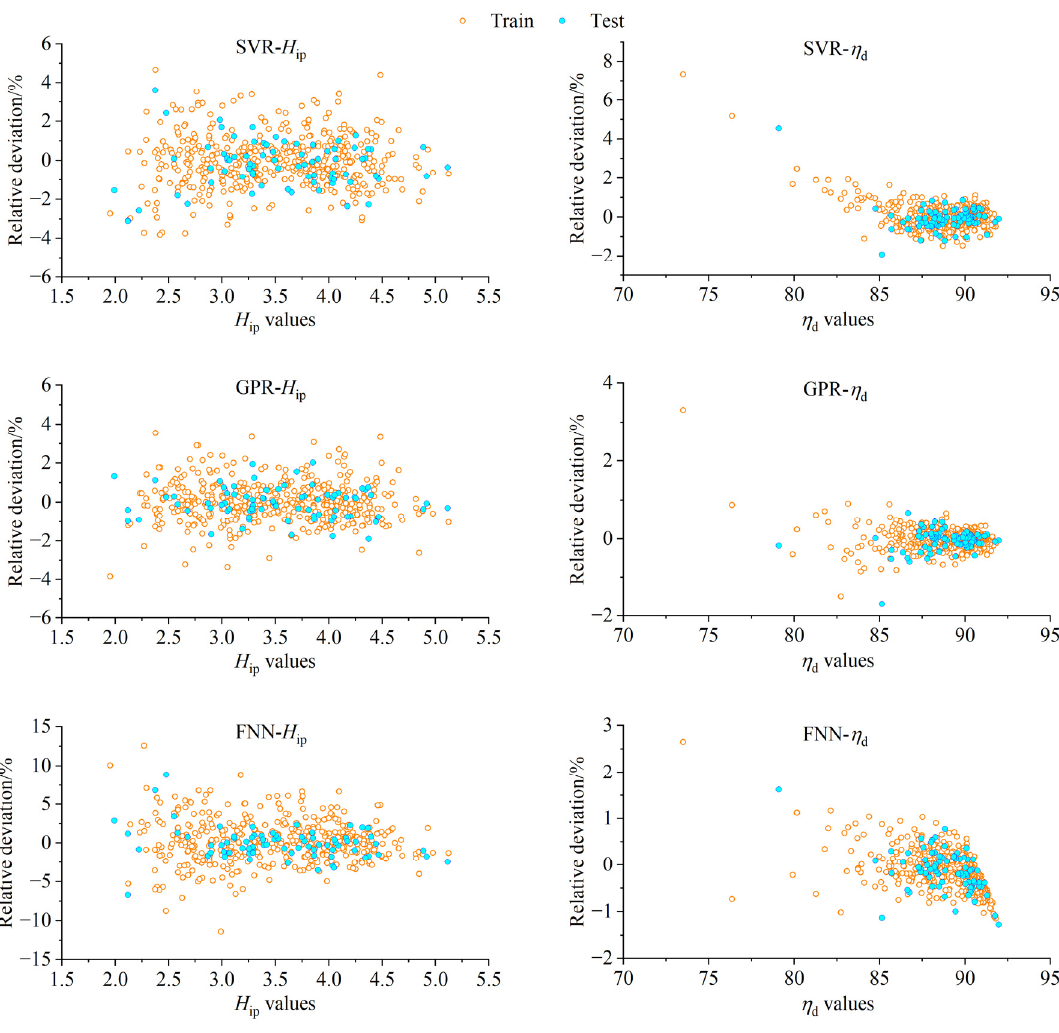
Figure 10. The relative deviation in H ip 2 and η d of the three models.